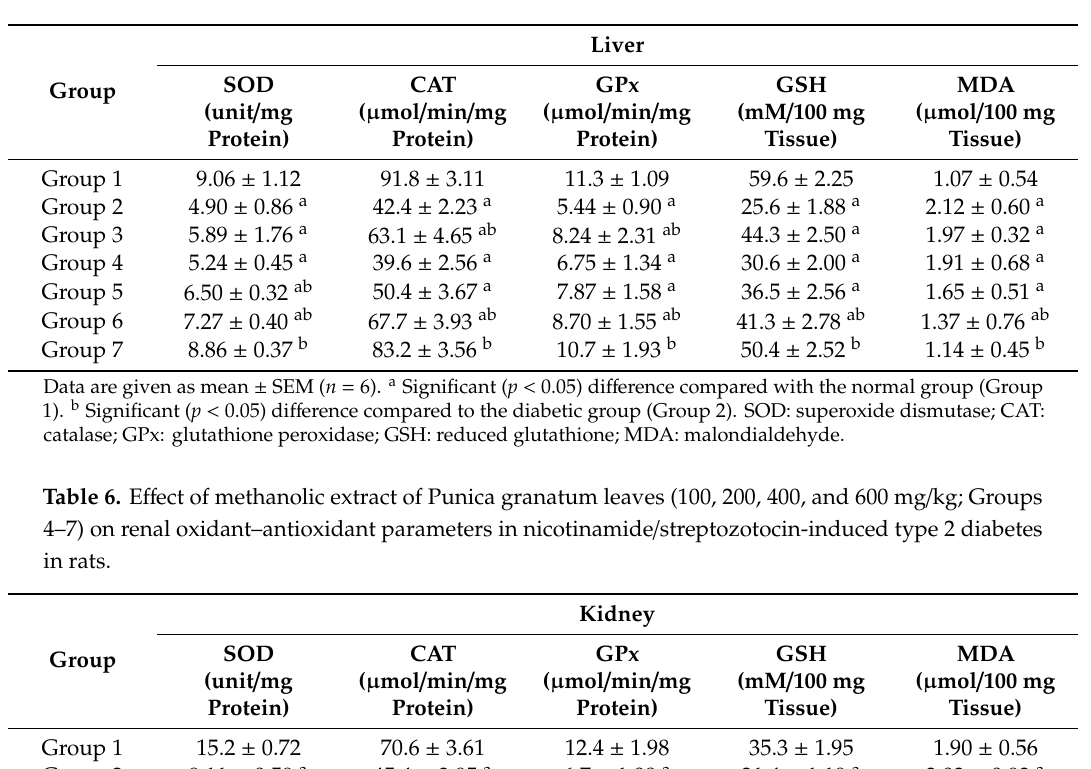
Table 5. E ff ect of methanolic extract of Punica granatum leaves (100, 200, 400, and 600 mg / kg; Groups 4–7) on hepatic oxidant–antioxidant parameters in nicotinamide / streptozotocin-induced type 2 diabetes in rats.